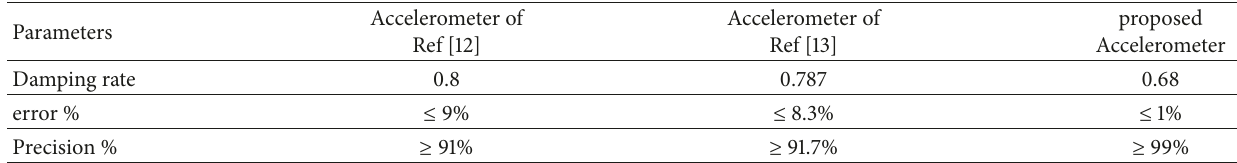
Table 2: Results comparison of three piezoelectric accelerometers.